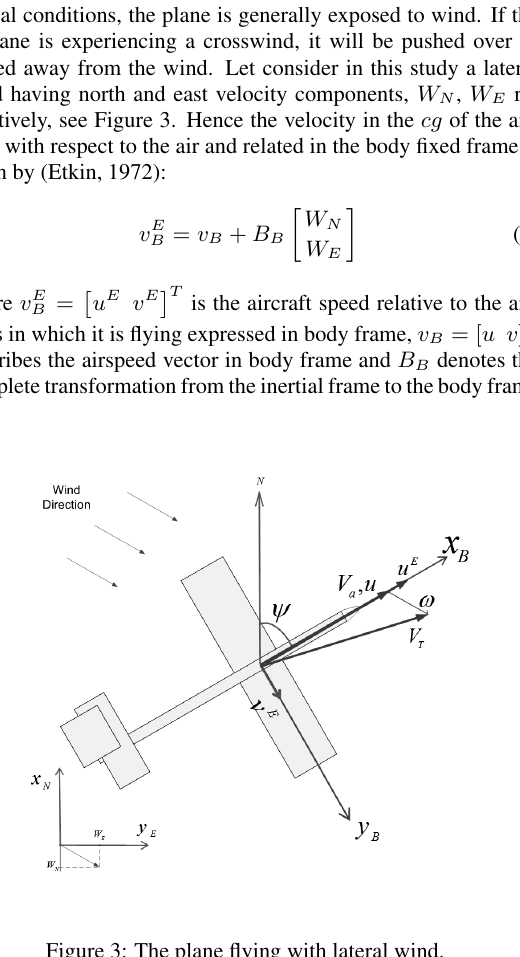
Figure 3: The plane flying with lateral